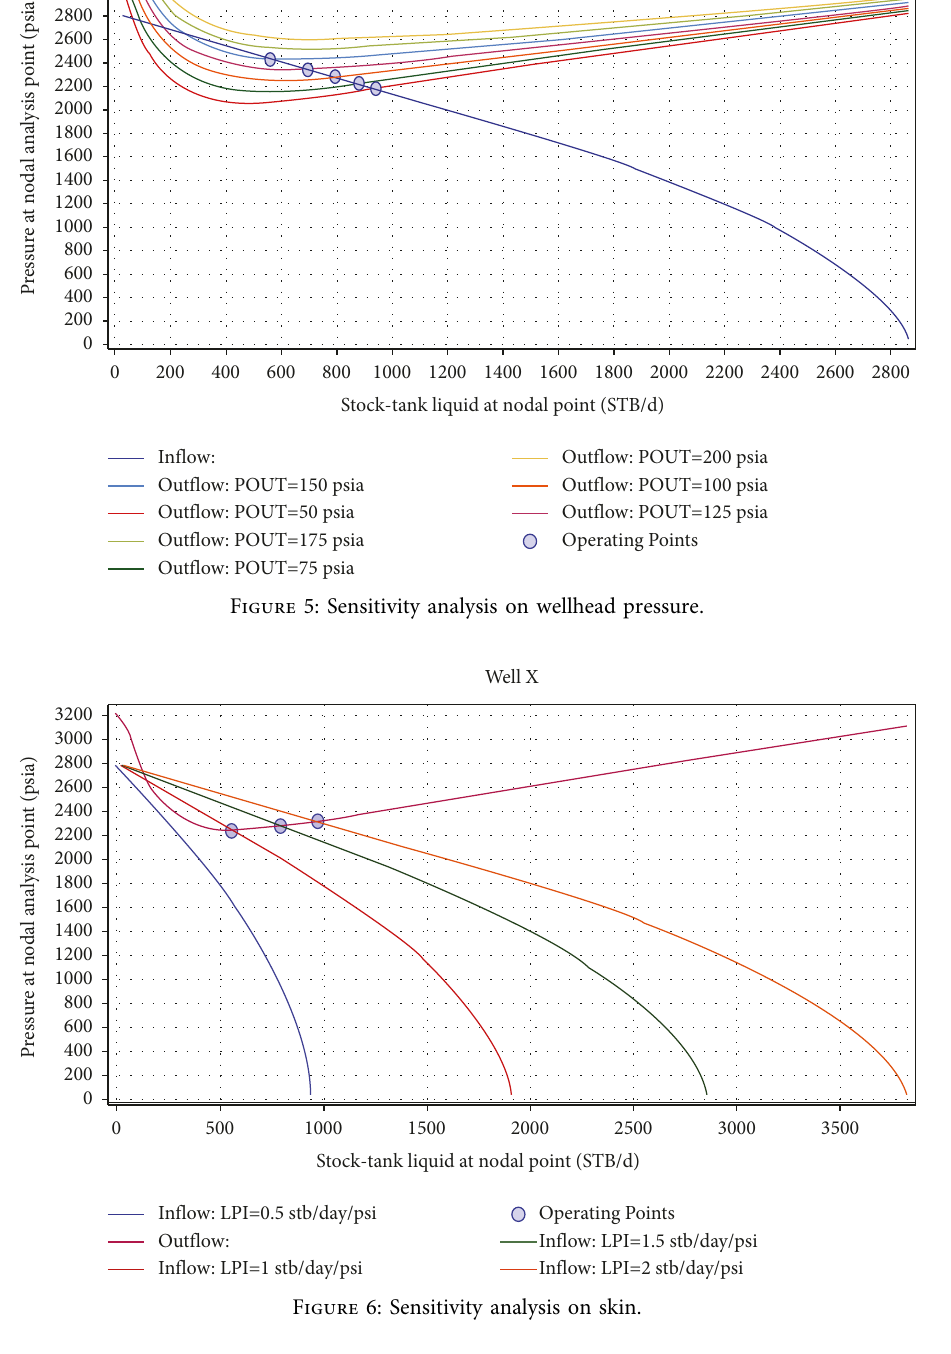
Figure 6: Sensitivity analysis on